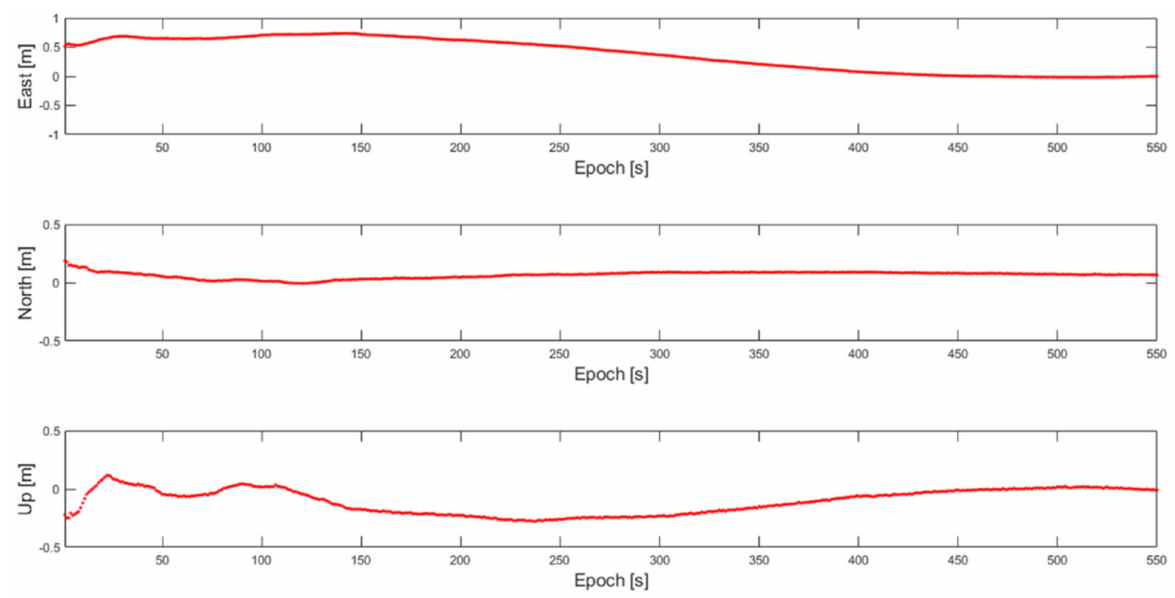
Figure 13. Distributions of v in normal and fault cases based on flight tests.